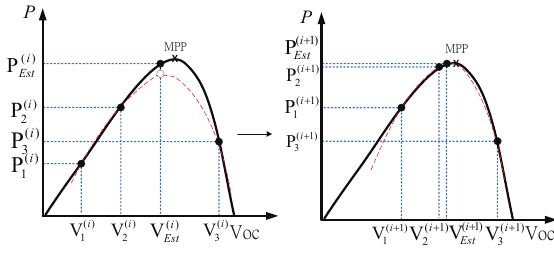
Figure 7. NQI tracking process.